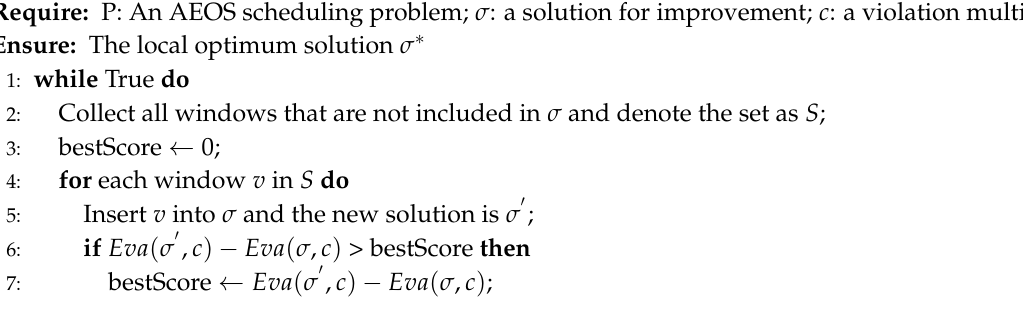
Algorithm 2. The Improvement